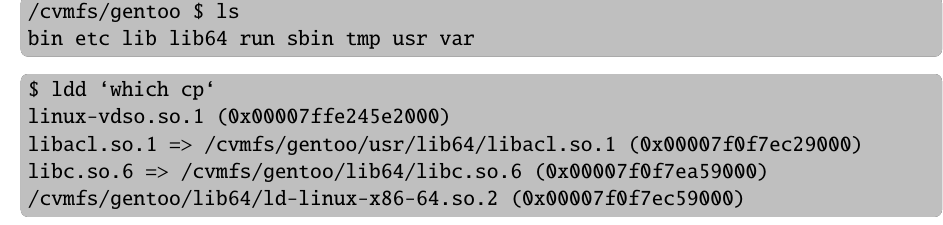
Figure 3. Example of a Gentoo Prefix EPREFIX=/cvmfs/gentoo . FHS directory layout is shown in the upper figure, and dynamic linking inside EPREFIX is shown in the lower